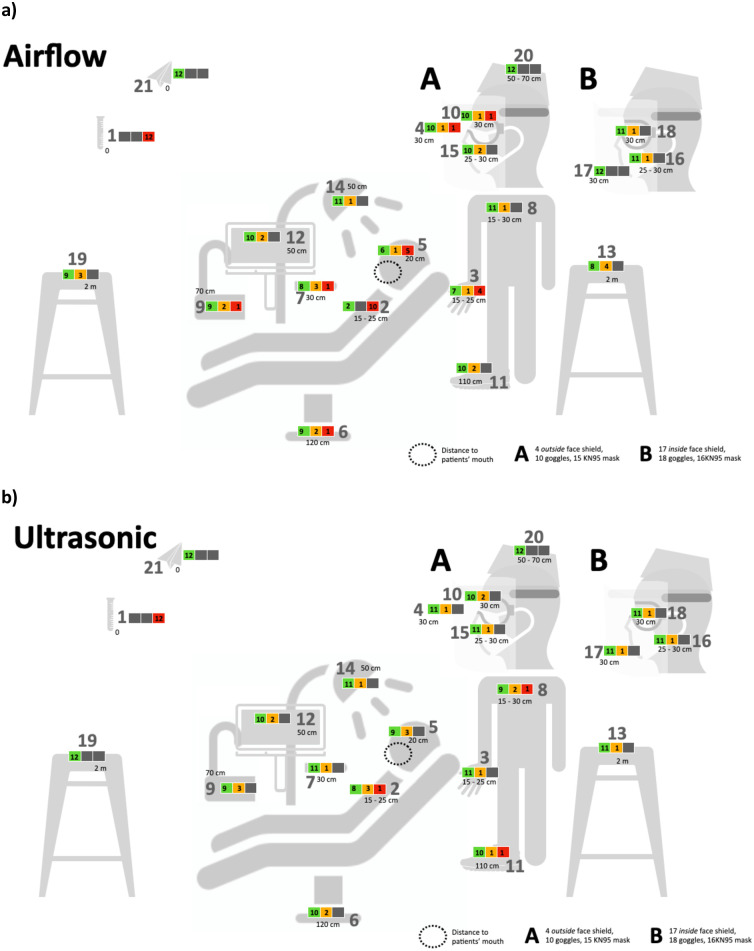
Clinical practice set-up and sample localization.Contamination in respect to the location is shown in a small traffic-light (according to
Table 1). a) Airflow b) Ultrasonic.